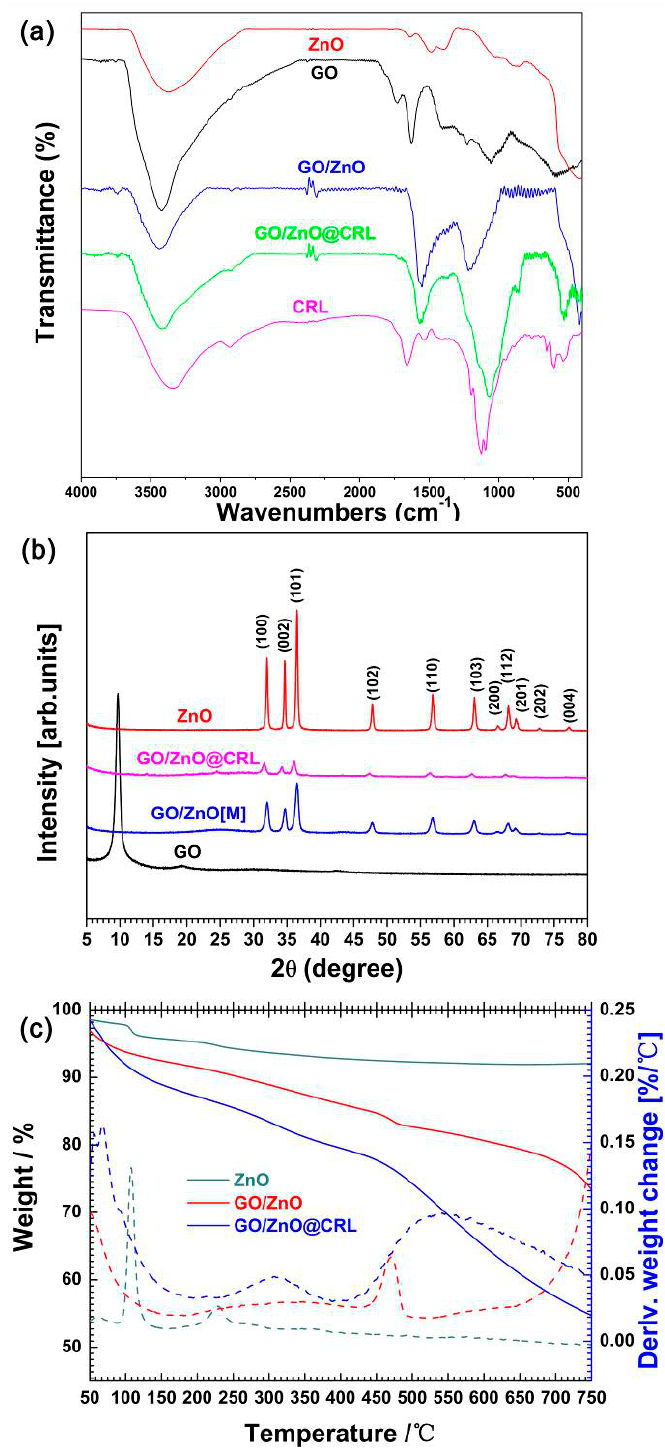
Figure 3. ( a ) The FT-IR spectra of GO, GO/ZnO, ZnO, CRL and GO/ZnO@CRL; ( b ) the XRD patterns of GO, ZnO, GO/ZnO and GO/ZnO@CRL; ( c ) the TG porfiles of GO/ZnO, ZnO and